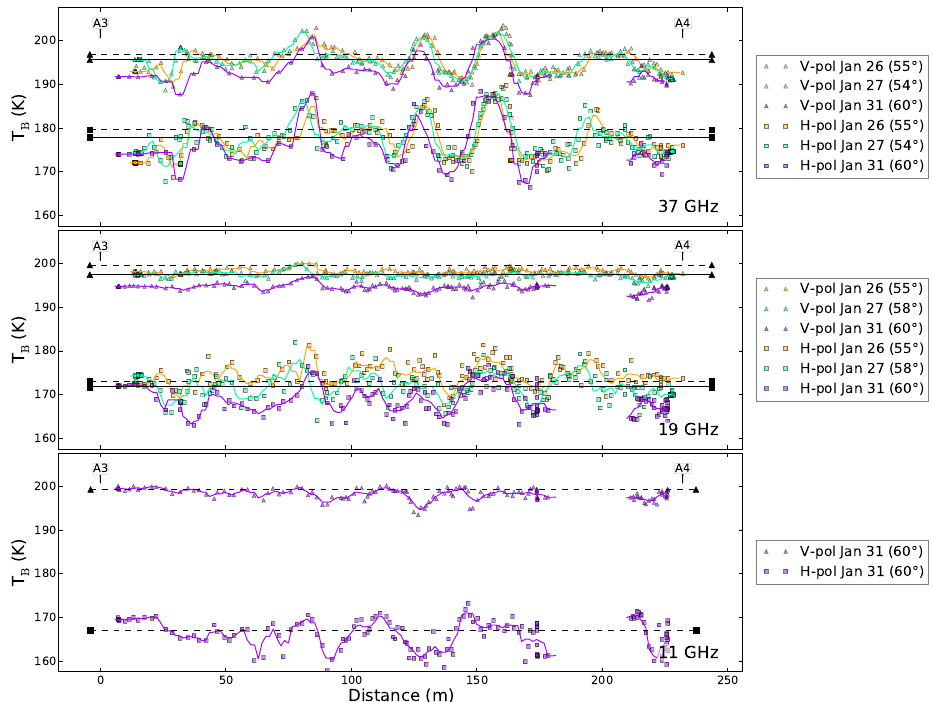
Figure 4. Brightness temperature measured along the A3–A4 transect on different dates (26, 27 and 31 January) for three frequencies (11, 19 and 37GHz) and nearly constant incidence angle (its mean value along the transect is indicated in the legend). The symbols represent individual measurements at vertical polarization (triangles) and horizontal polarization (squares). The solid curves show the running average for a 6m window. The horizontal black lines show the mean brightness temperature during the campaign of the pixel containing Dome C from SSM/I (solid line) and WindSat (dashed